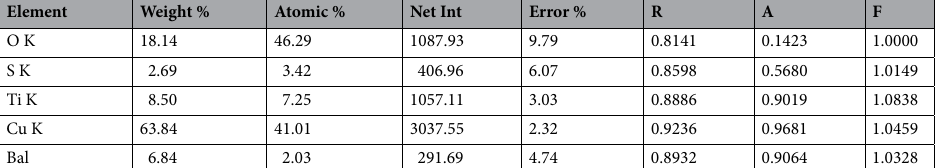
Table 3. Representative the EDX data from Fig. 5 of Cu with 40 wt.% of TiO 2 nanoparticles and you can see the existence of Cu and Ti and O atoms with a higher ratio of 63.84, 8.50, and 18.14 respectively.